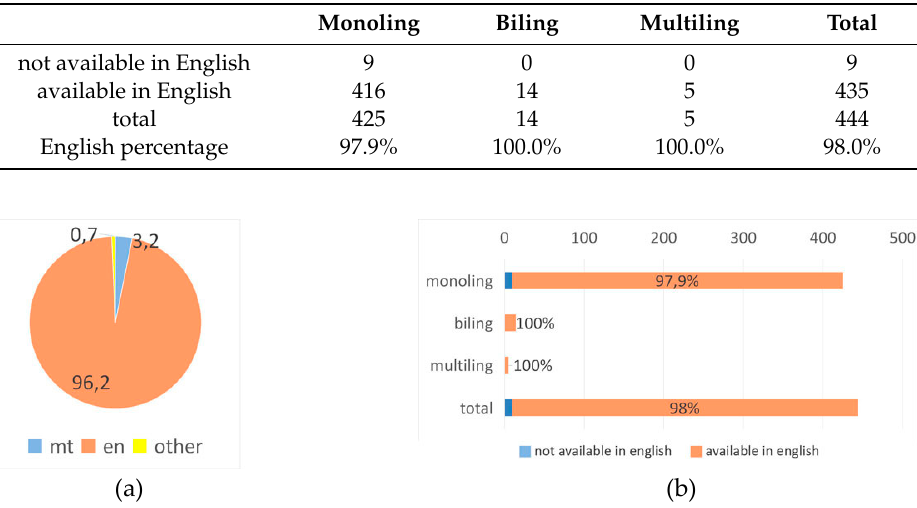
Table A38. English language availability (mt).